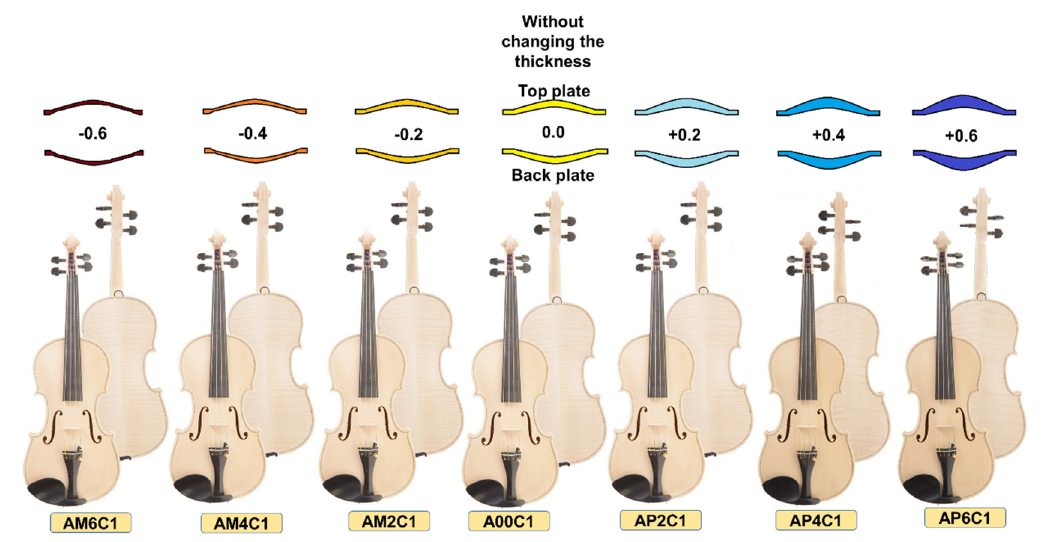
Figure 1. The tested violins.